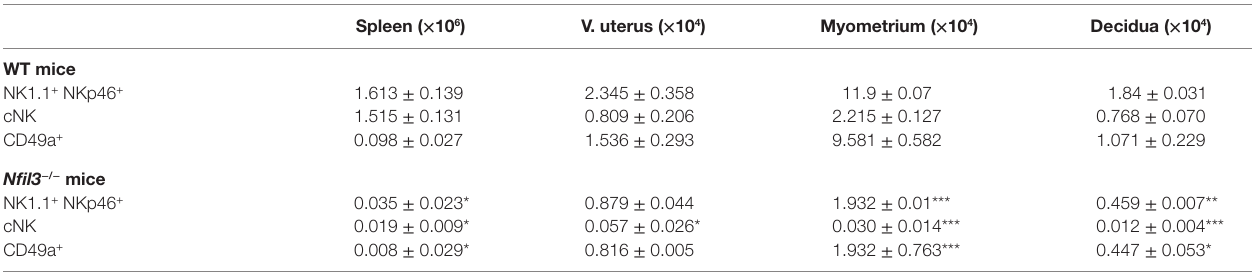
TaBle 1 | numbers of uterine cD49a + and cD49a − nK cells in WT and Nfil3 − / −